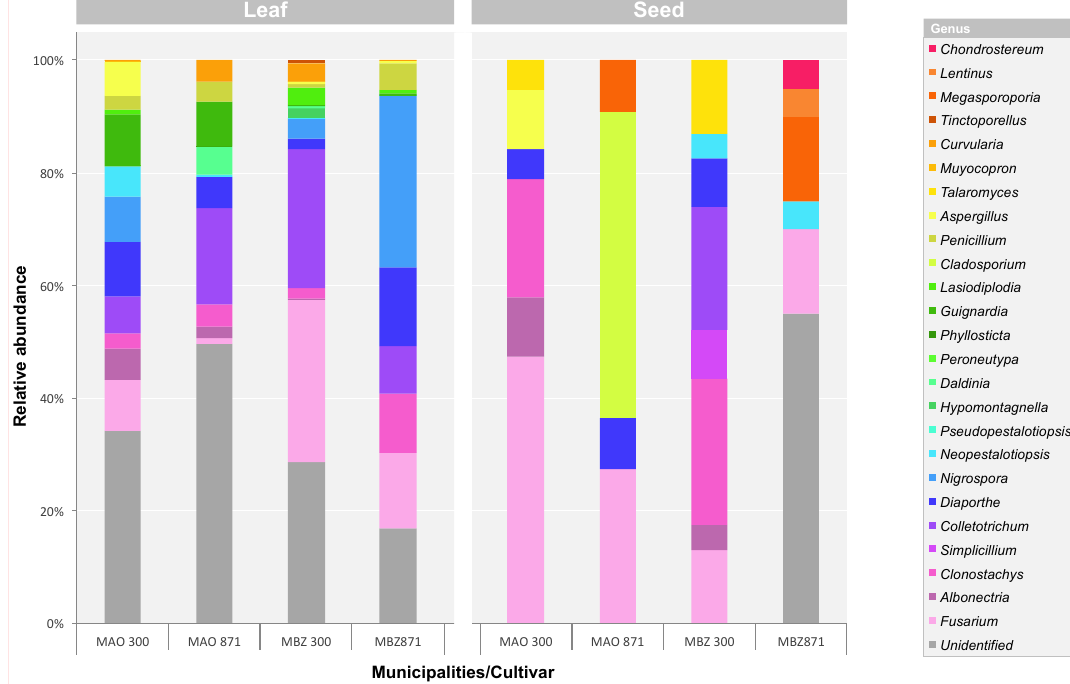
Figure 3. Genus level taxonomic composition of the fungal isolates obtained from guarana leaves and seeds of susceptible (BRS300) and resistant (BRS871) plant genotypes from Manaus (MAO) and Maués (MBZ), Amazonas, Brazil.